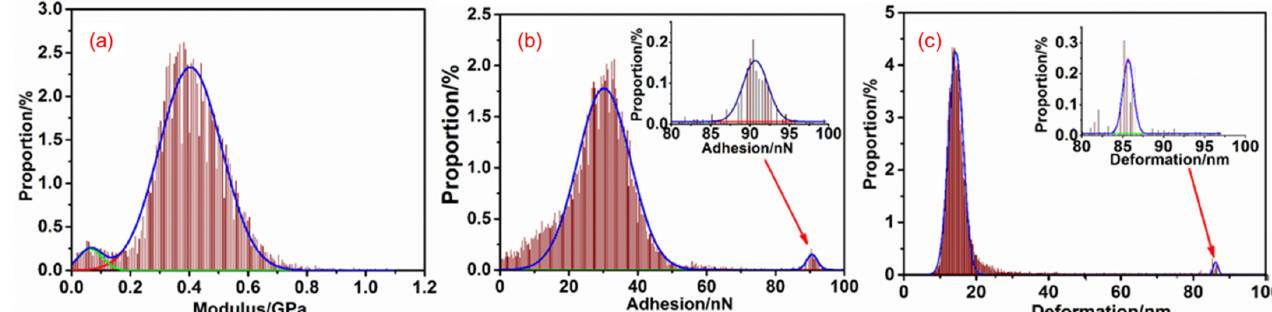
Figure 8. Statistical distribution of microcrack elastic modulus ( a ), adhesion ( b ), and deformation ( c ).